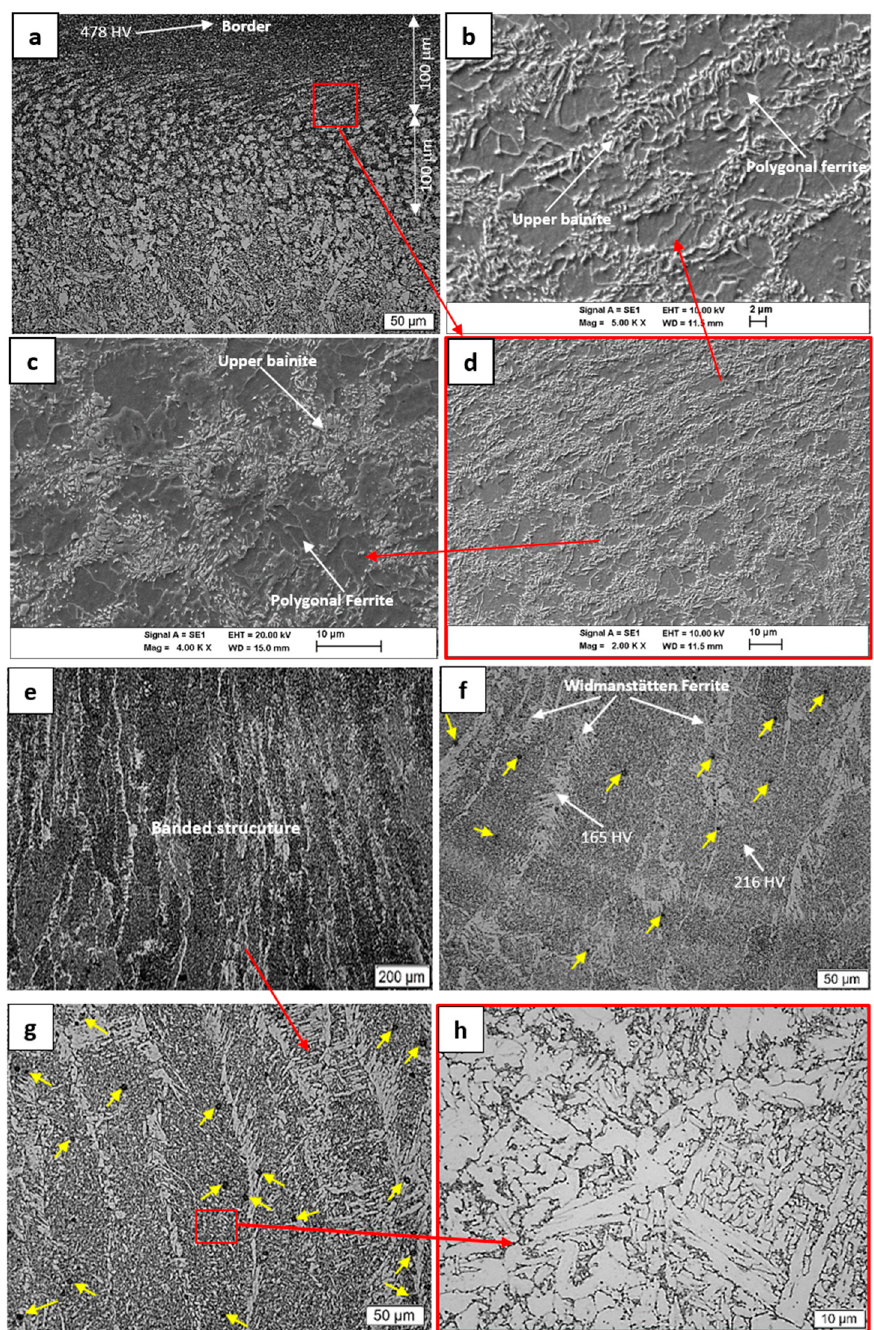
Figure 8. ( a ) Distribution of the upper bainite layer showing elongated grains; ( b ) detailing of the grain distortion in the first 100 µm; ( c ) distribution of the upper bainite in the boundaries of the old austenitic grain; ( d ) detail of ( a ); ( e ) banded structure; ( f , g ) detail of ( e ) showing the distribution of inclusions in the matrix; ( h ) detail showing the matrix; ( g ) large magnification of the matrix. The yellow arrows indicate inclusions distributed in the matrix.